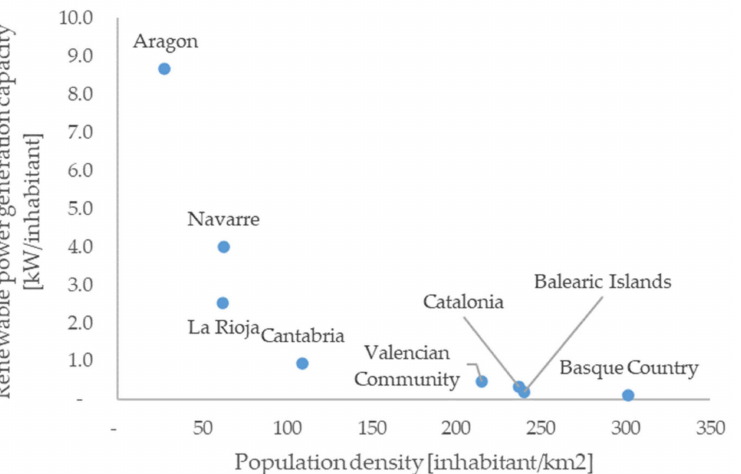
Figure 3. Renewable power generation capacity and population density relationship by 2026, elabo- rated with data from